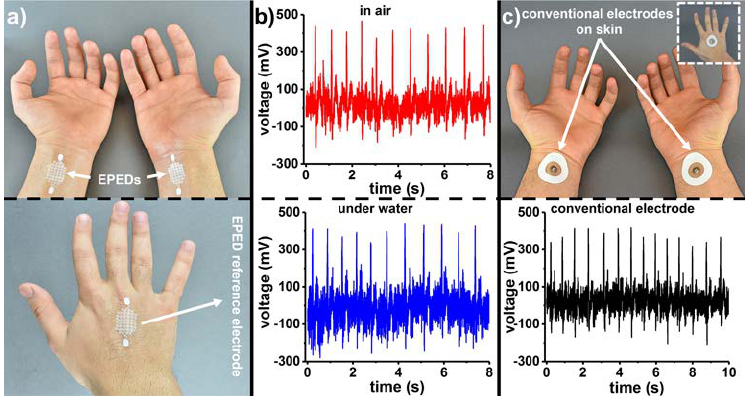
Figure 3. Comparison between the performance of razor printed copper-based EPEDs and conventional foam electrodes to record ECG signals: ( a ) Top: EPED measurement and ground electrodes used to record ECG signals from the wrist of a subject. Bottom: Reference EPED electrode; ( b ) Top: ECG signals recorded in air using razor printed EPEDs. Bottom: ECG signals recorded with both hands under water; ( c ) Top: Conventional foam electrodes placed at the same locations of the wrist as ( a ). The inset shows the location of the reference foam electrode on the back of the hand. Bottom: ECG signals recorded in air using conventional foam electrodes.